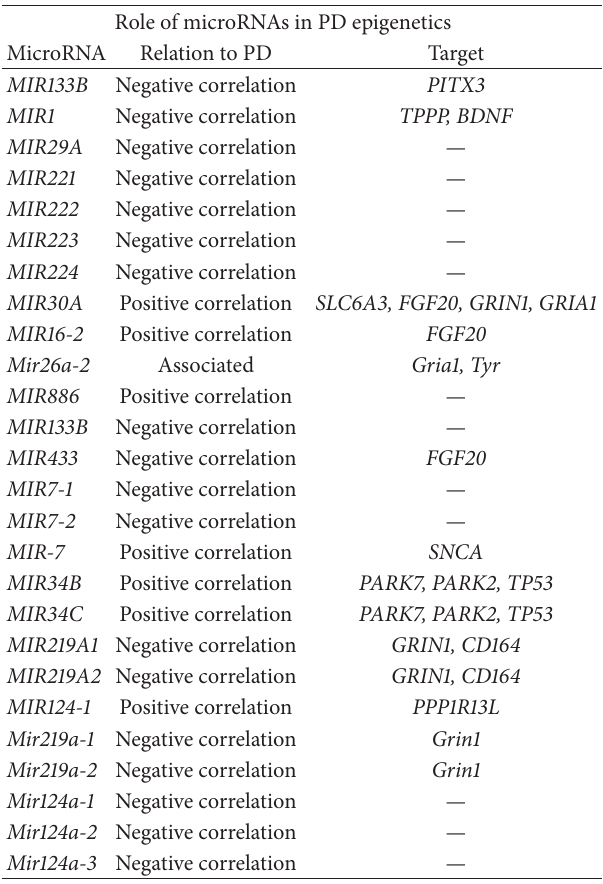
Table 1: Role of microRNAs in PD epigenetics. 26 microRNAs have been identified that have been reported to control PD pathways. Positive and negative correlations of these microRNAs with PD mean if they are inducing or inhibiting the diseasestate, respectively. Also, we have enlisted the target genes for retrieved